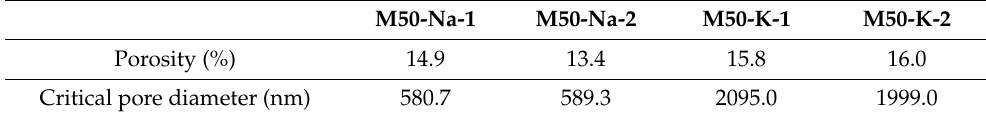
Table 7. Mercury intrusion porosimetry (MIP) parameters for M50-K and M50-Na